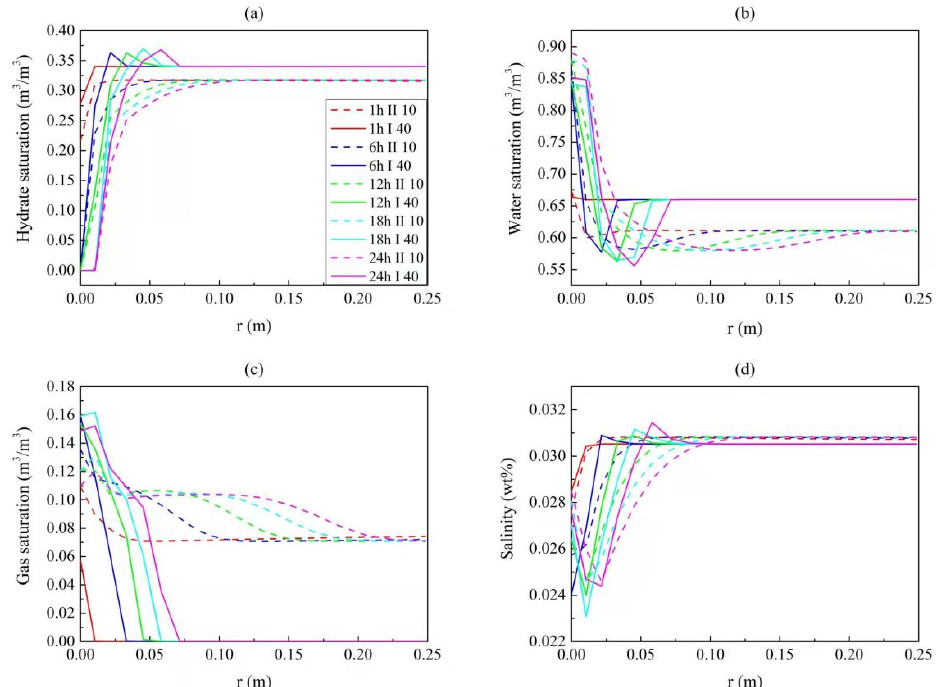
Figure 6. Physical property distribution curves of layer II at 10 m from the bottom of the hydrate reservoir and layer I at 40 m from the bottom of the hydrate reservoir at different drilling fluid invasion times: ( a ) hydrate saturation distribution curves; ( b ) water saturation distribution curves; ( c ) gas saturation distribution curves; ( d ) salinity distribution curves.